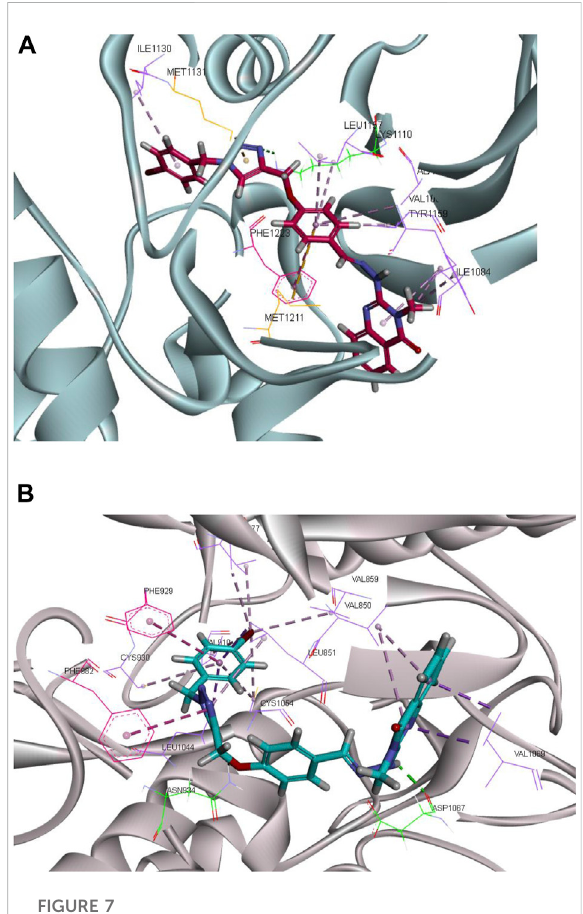
FIGURE 7 Molecular docking analysis of the interaction of CM9 with MET receptor and established FLT4 (VEGFR3) homology model. Interactions and binding modes of CM9 with MET (A) and VEGFR3kinase (B) areshown. VanderWaals,hydrogenbond, pi – pi and pi – sulfur interactions were colored as light purple, light green, light pink and orange. Images were created by Discovery Studio Client